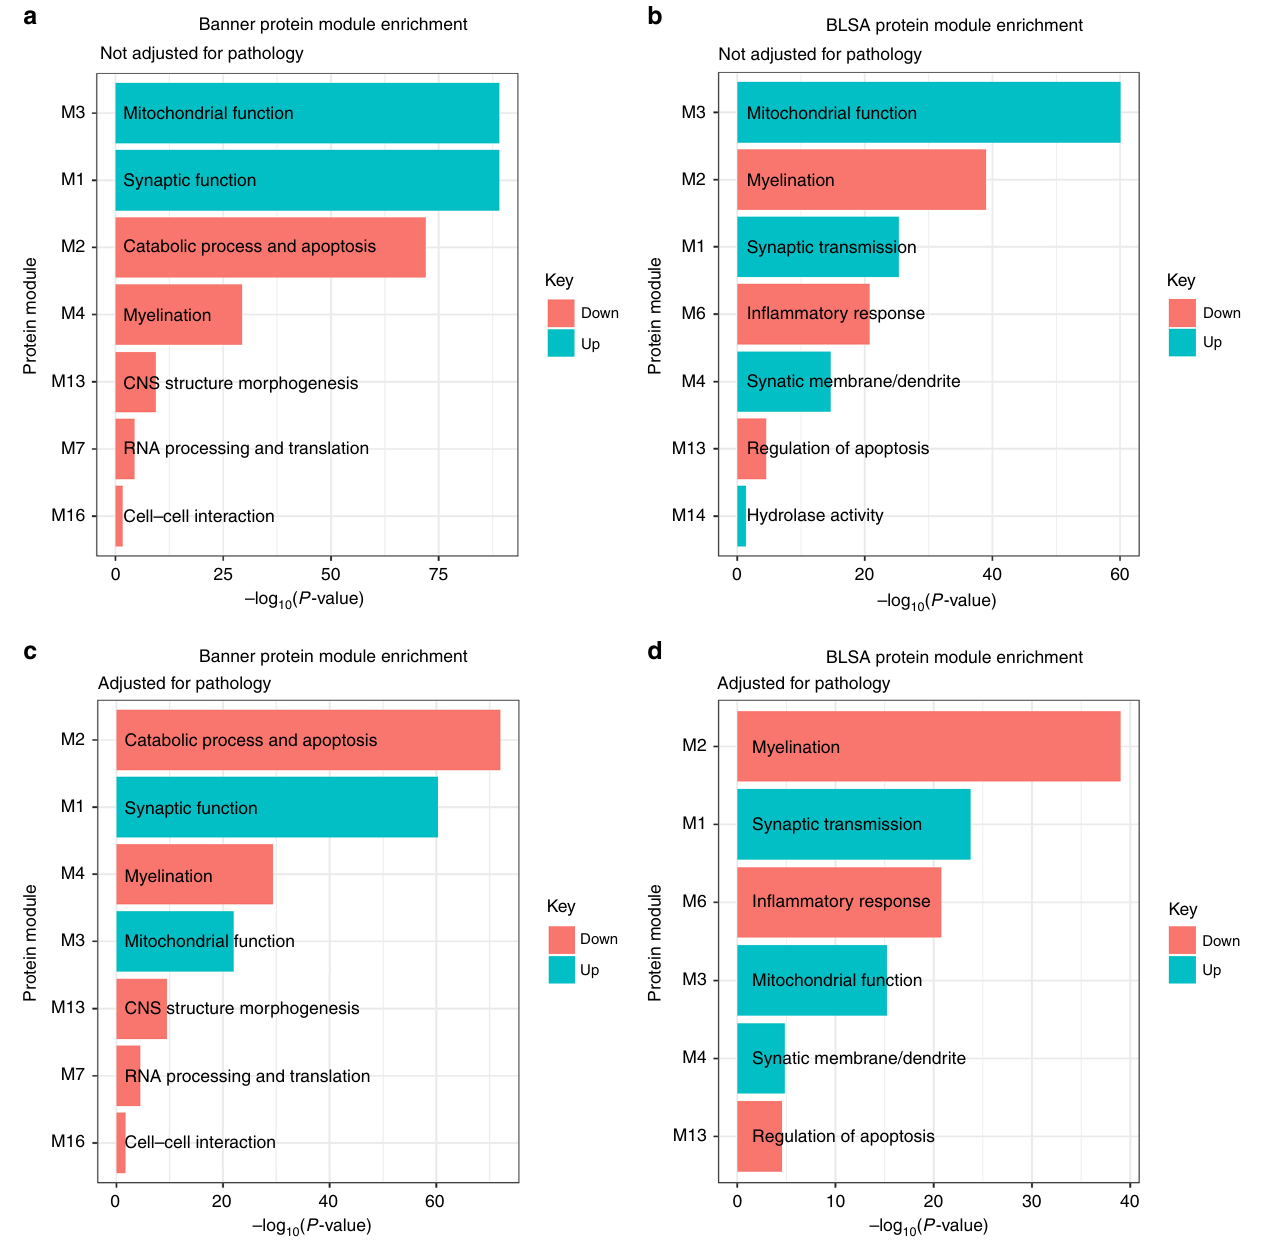
Fig. 5 Modules enriched for cognitive trajectory-associated proteins. This fi gure summarizes the protein co-expression modules that are enriched for cognitive trajectory-associated proteins for each cohort with and without adjustment for neuropathologies. Enrichment was determined by Fisher ’ s exact test and reported p -values are adjusted for FDR. There are 579 cognitive trajectory-associated proteins in Banner and BLSA cohorts, which were divided into lower-abundance proteins in cognitive stability (229 proteins, colored in salmon) and higher-abundance proteins in cognitive stability (350 proteins, colored in turquoise), respectively. a Banner protein module enrichment; b BLSA protein module enrichment. After adjusting for β -amyloid plaques and neuro fi brillary tangles, there were 232 cognitive trajectory-associated proteins, and enrichment was performed separately for lower-abundance proteins in cognitive stability (81 proteins, colored in salmon) and higher-abundance proteins in cognitive stability (151 proteins, colored in turquoise), respectively. c Banner protein module enrichment; d BLSA protein module enrichment. Source data are provided as a Source Data fi